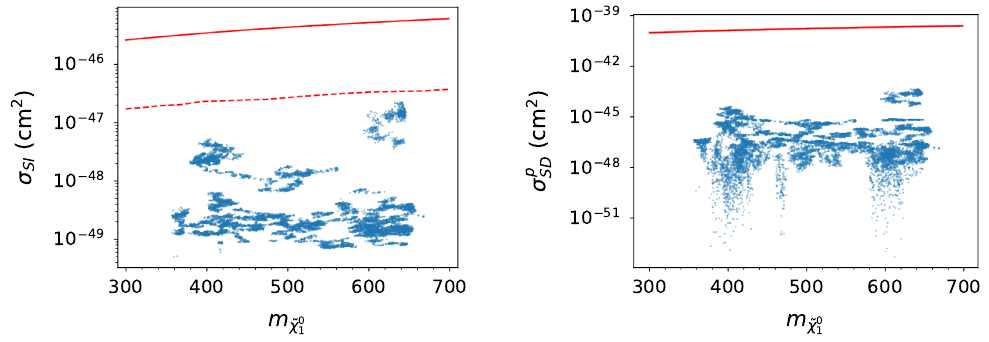
Figure 14 . The direct detection limits for spin dependant and spin independent cross-sections are shown with the experimental limit plotted. The solid line indicates the XENON1T limits [74], while the dashed line in the first panel indicates the expected limit for the XENONnT [82] experiment. We have precluded a representation of the neutron direct detection calculation as all data points are far away from the exclusion limit, much like the proton calculation of the